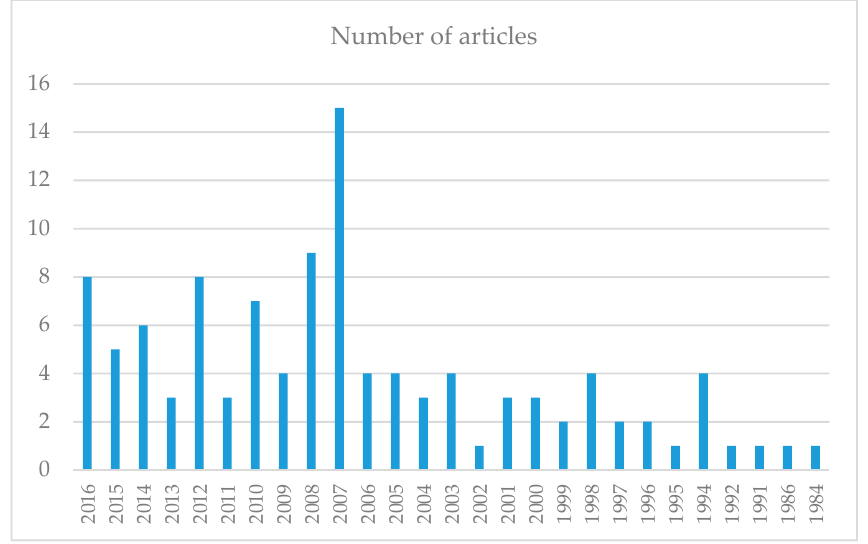
Figure 2. Nations that promote research on technology transfer in offset policies. Source: Research Data.